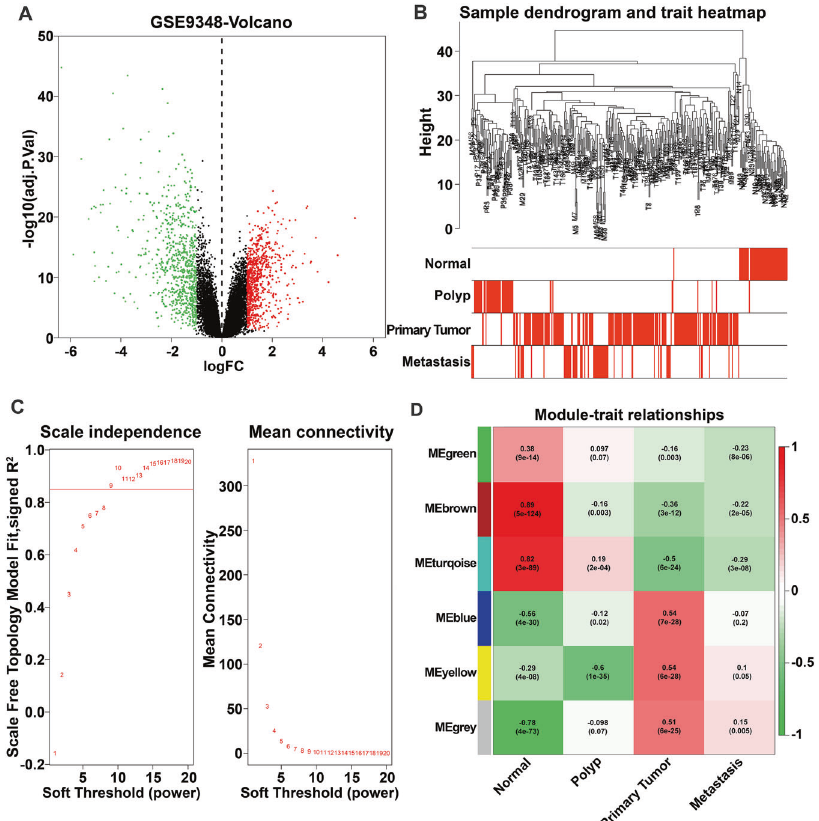
Fig. 1 Identi fi cation of DEGs in GSE9348 dataset and the key gene modules related to tumor progression in GSE41258 dataset. A Volcano plots of DEGs in GSE9348 dataset. Red and green dots respectively indicated the upregulated and downregulated genes. B The heatmap of sample dendrogram and trait. The 1232 genes of 355 samples in GSE41258 were used to apply WGCNA. The clinical traits were normal, polyp, primary tumor, and metastasis. C Analysis of the scale-free fi t index for various soft-thresholding power ( β ). Analysis of the mean connectivity for various soft-thresholding power. D Heatmap of the correlation between module eigengenes and the clinical trait of CRC. The blue module with 270 genes was most signi fi cantly positive associated with primary tumor and also negative associated with normal and polyp